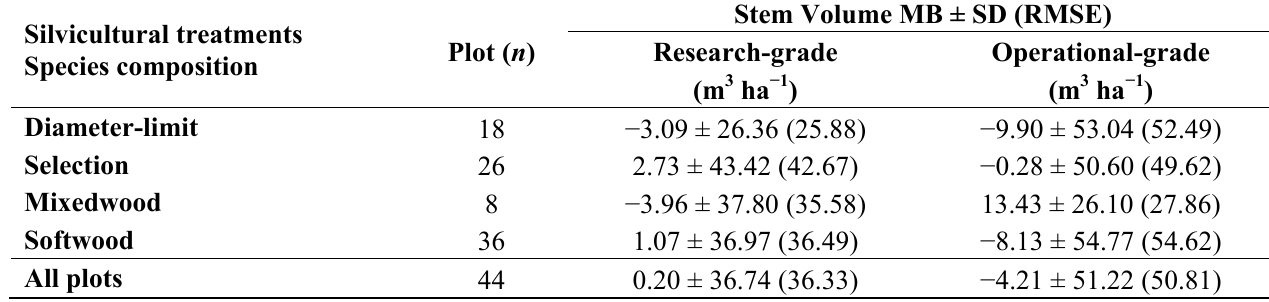
Table 6. Mean bias (MB) with standard deviation (SD) and root mean square error (RMSE) by silvicultural treatments and species composition. The prediction models were calibrated based on 44 research- and 44 operational-grade plot data. Mixedwood plots had a percent of basal area of softwood <70, and softwood-dominant plots had a percent of basal area of softwood